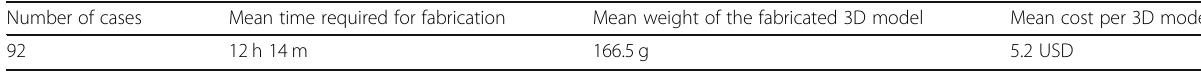
Table 3 Overview of the fabrication of our 3D models in orthognathic surgery Number of